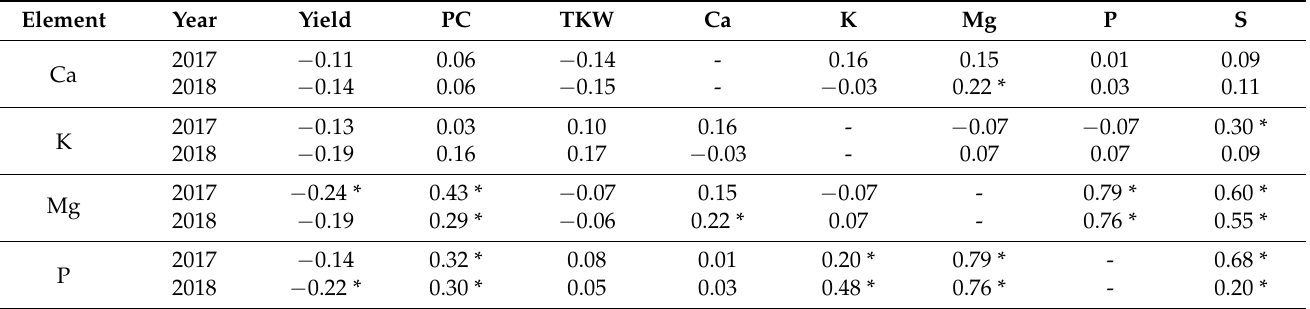
Table 1. Correlation coefficients between agronomic traits and element concentrations in grain,